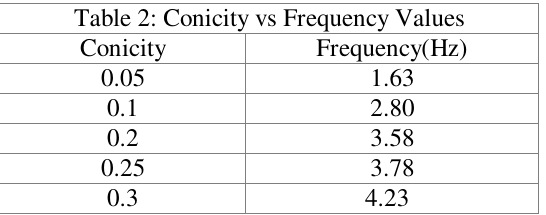
Table 2: Conicity vs Frequency Values